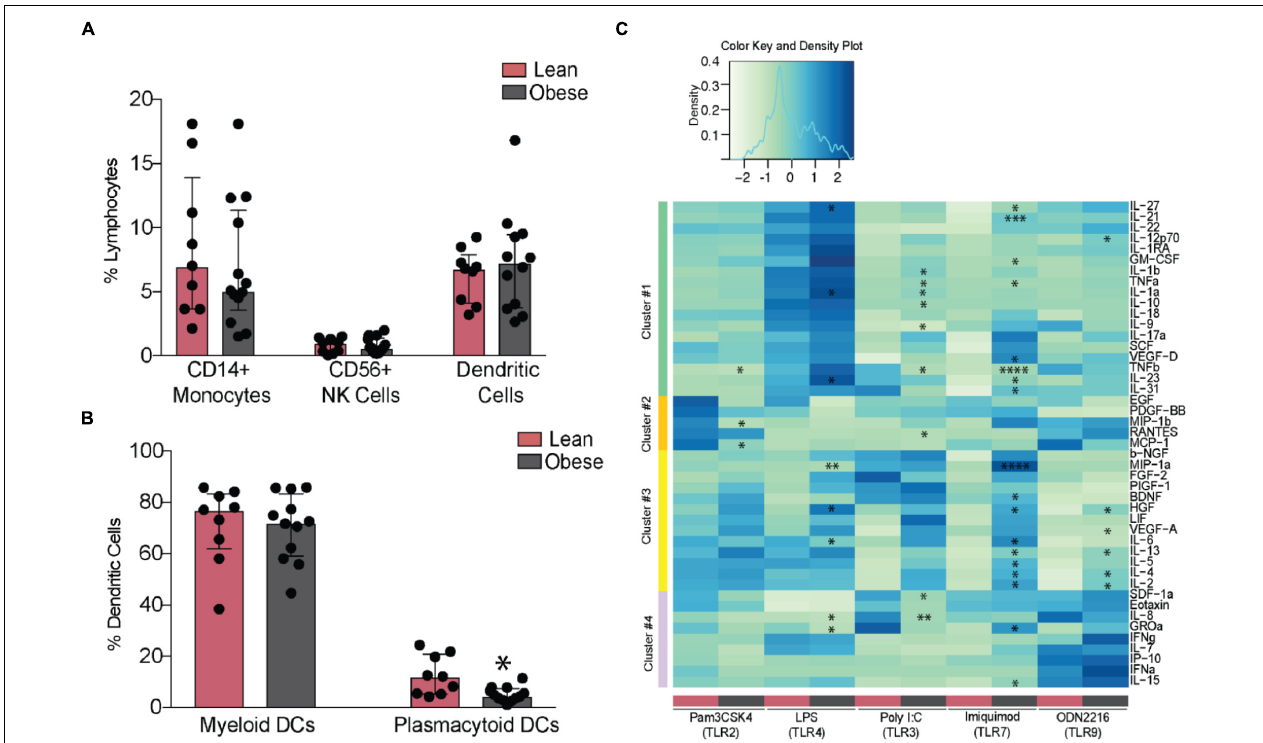
FIGURE 3 | Maternal obesity establishes a hyper-responsive phenotype in circulating monocytes. (A) Changes in the frequency of circulating CD14+ monocytes, CD56+ NK cells, and DCs (B) Relative frequencies of myeloid and plasmacytoid DCs. (C) Clustered heatmap of cytokine, chemokine, and growth factor responses following stimulation with TLR2 (Pam3CSK4), 3 (PolyI:C), 4 (LPS), 7 (Imiquimod), and 9 (ODN2216) agonists. Responses are reported as scaled post stimulatory concentrations in pg/mL. Significant differences between groups are indicated as follows: ∗ p < 0.05, ∗∗ p < 0.01, ∗∗∗ p < 0.001, and ∗∗∗∗ p < 0.0001. All of the bar graphs show median values with inter quartile ranges